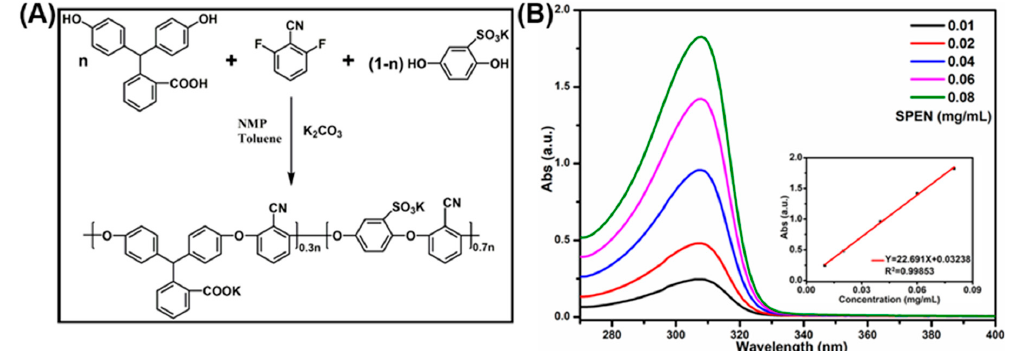
Figure 1. The synthesis route of SPEN and the UV-Vis absorption spectra of SPEN in aqueous solution at different concentrations. at different